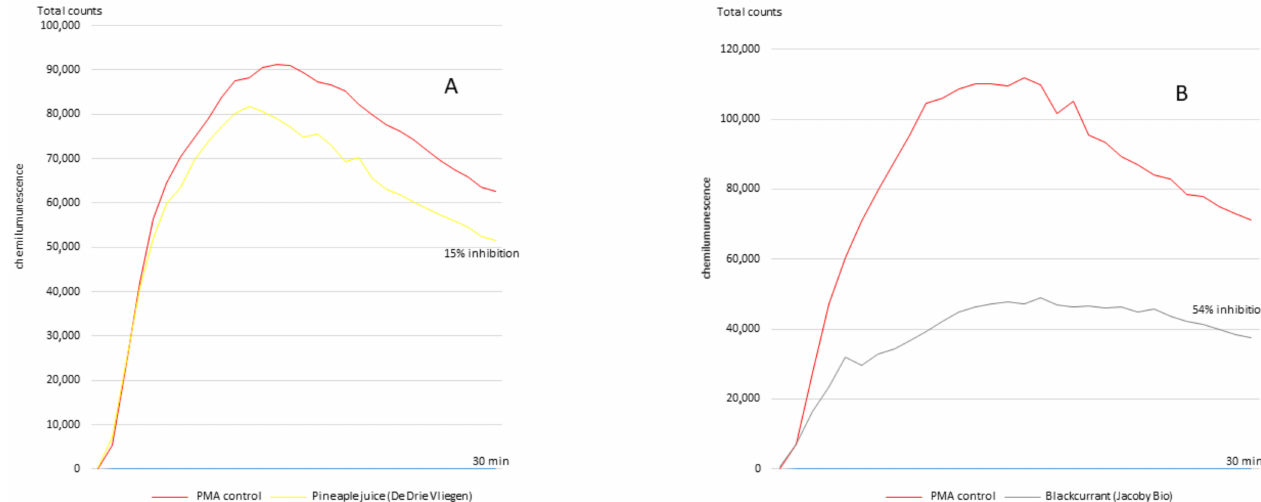
Figure 1. Examples of superoxide anion inhibition by pineapple (De Drie Wilgen) or blackcurrant (Jacoby bio) juice (panels ( A ) and ( B ), respectively) in PMA-activated whole human blood, as determined by chemiluminescence detection (30 min). The area under the curve for each analyzed juice yields the percentage of superoxide anion inhibition in relation to the PMA